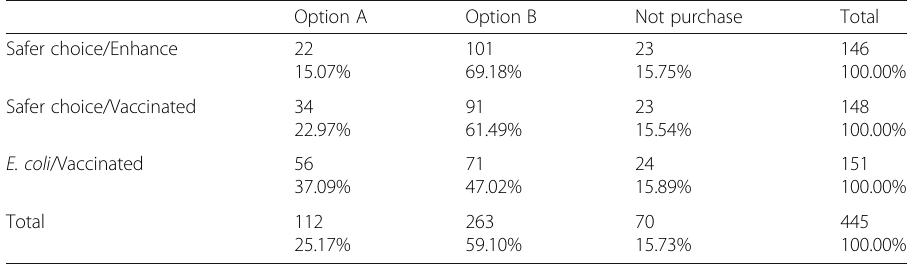
Table 4 Statistics of subjects ’ response to ground beef options Option